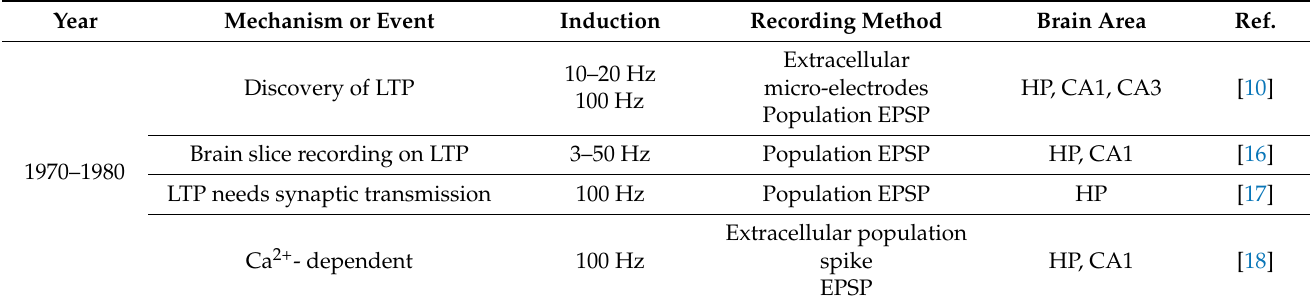
Table 1. The timeline and recordings of long-term potentiation studies.